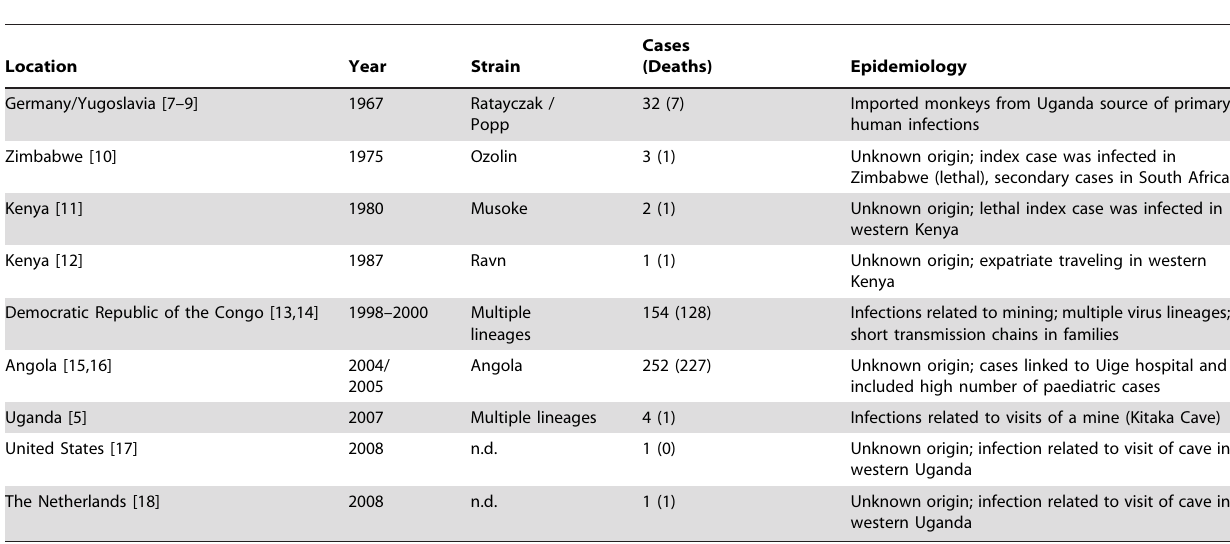
Table 1. Documented outbreaks/episodes/cases of Marburg Hemorrhagic Fever (MHF).